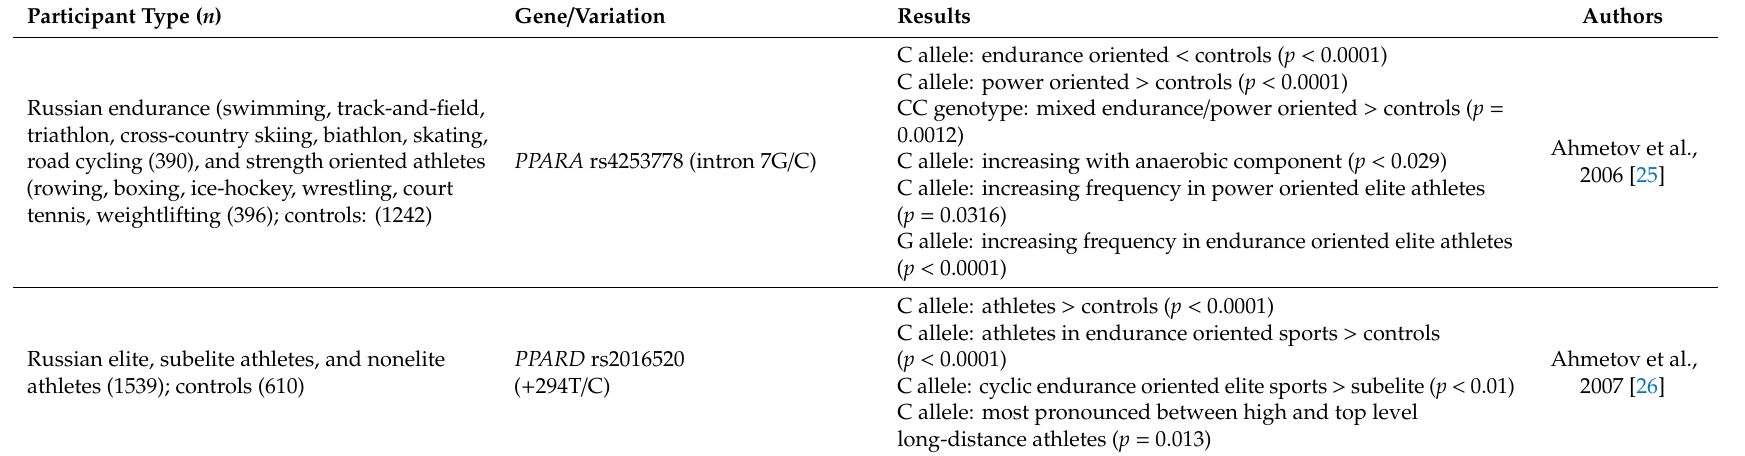
Table 2. PPAR alleles and genotypes in elite and subelite athletes and their di ff erences among disciplines. TGS, total genetic